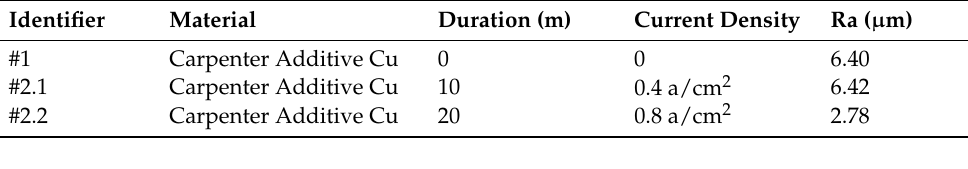
Table 7. Surface roughness of L-PBF as built and electropolished copper.